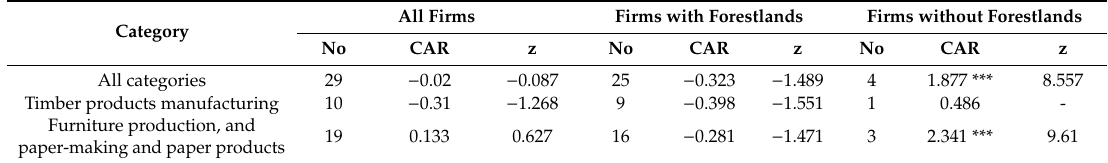
Table 6. Results of testing policy